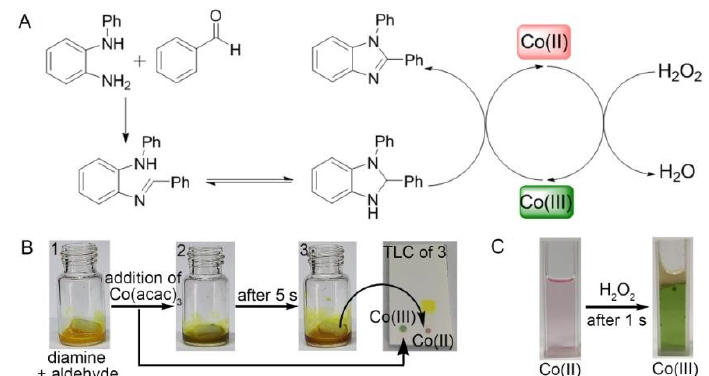
Figure 1. Mechanistic investigation. ( A ) Proposed redox catalysis mechanism, ( B ) color change upon addition of 1 mol% of Co(acac) 3 to the mixture of 1.05 mmol of benzaldehyde and 1.0 mmol of N -phenyl- o -phenylenediamine under solvent-free conditions without peroxide, and ( C ) instant color change of Co(II) to Co(III) in CH 2 Cl 2 (Co(acac) 2 , 4 × 10 −3 M, 2 mL) upon addition of H 2 O 2 (30% aq., 90 μ L, 100 eq.).